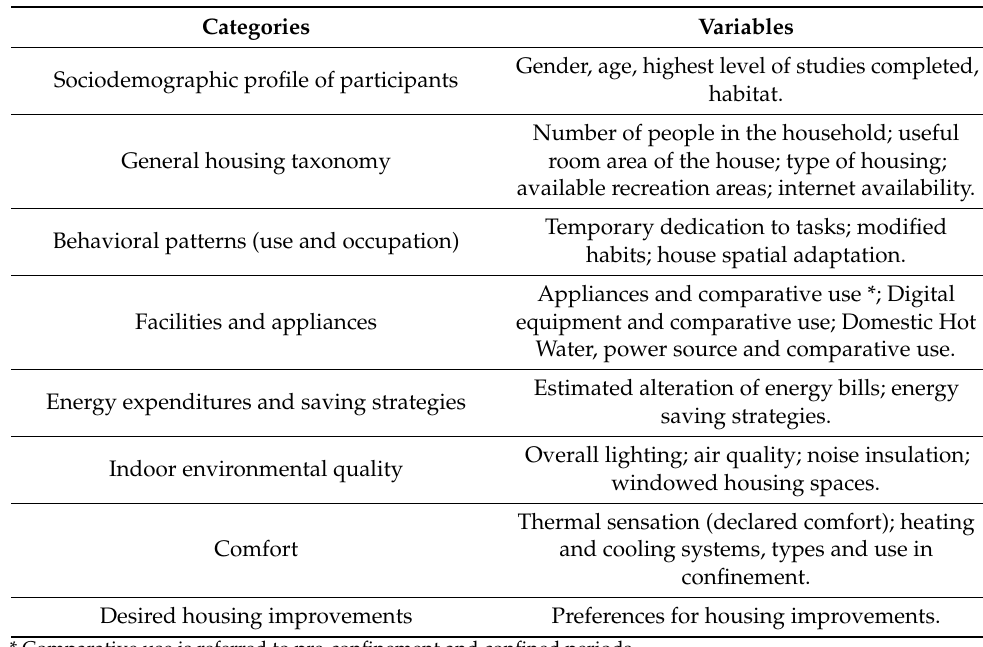
Table 1. Quantified categories and variables from the